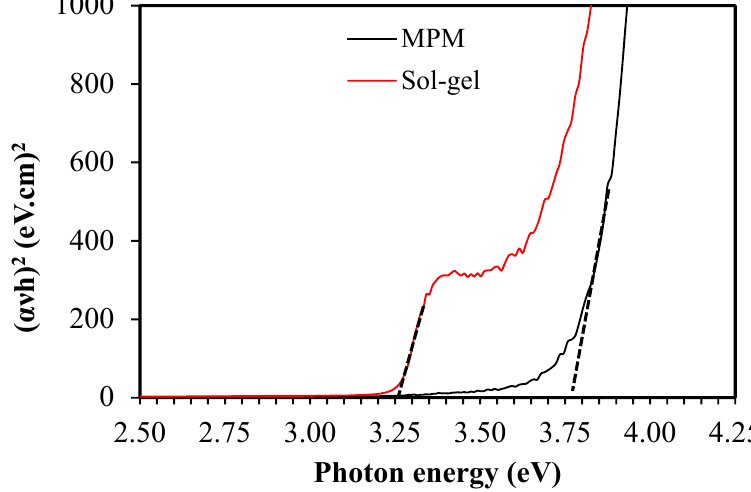
Figure 5. Plots of [ αν h] 2 versus photon energy of ZnO thin films fabricated via MPM and sol–gel methods.